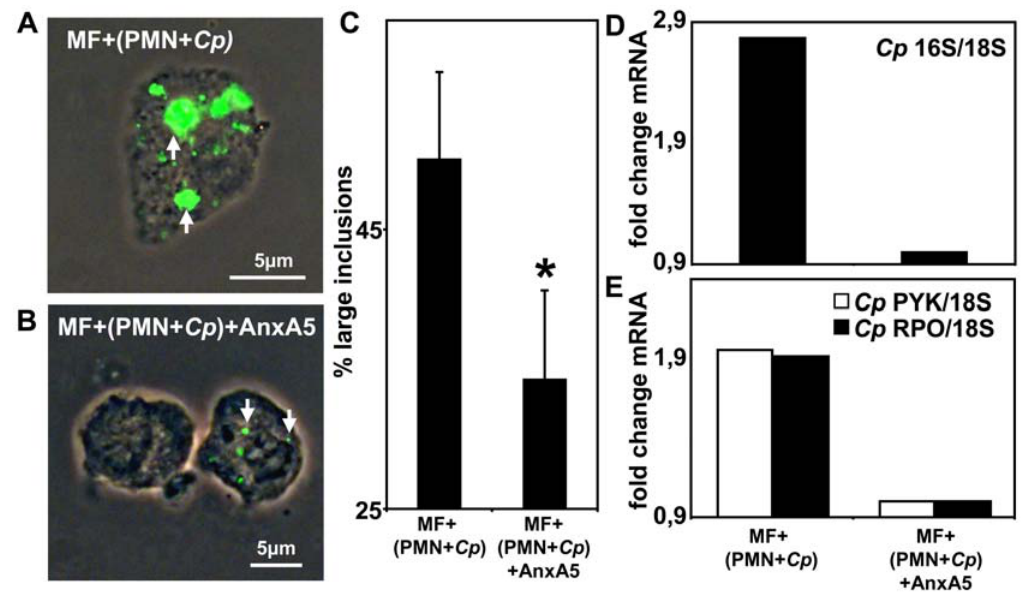
Figure 6. PS- dependent transmission of C.pneumoniae infection. Blocking of phosphatidylserine (PS) expression on C. pneumoniae - infected PMN by preincubation with recombinant AnxA5 significantly reduced the uptake of chlamydiae ( A, B ) and the formation of large inclusions ( C , p=0.02; n=3) as shown by fluorescence microscopy with FITC- labeled anti- C. pneumoniae LPS- staining (representative experiment out of 3, magnification 630 6 ) and calculation of a minimum of 200 cells/slide ( C ). Replicative activity of C. pneumoniae , indicated by the amount of 16S rRNA ( D ), pyk (open bars) and rpo (closed bars) mRNA expression compared to host cell 18S rRNA expression ( E ), decreased in MF when C. pneumoniae - infected PMN were preincubated with AnxA5 (representative experiment out of